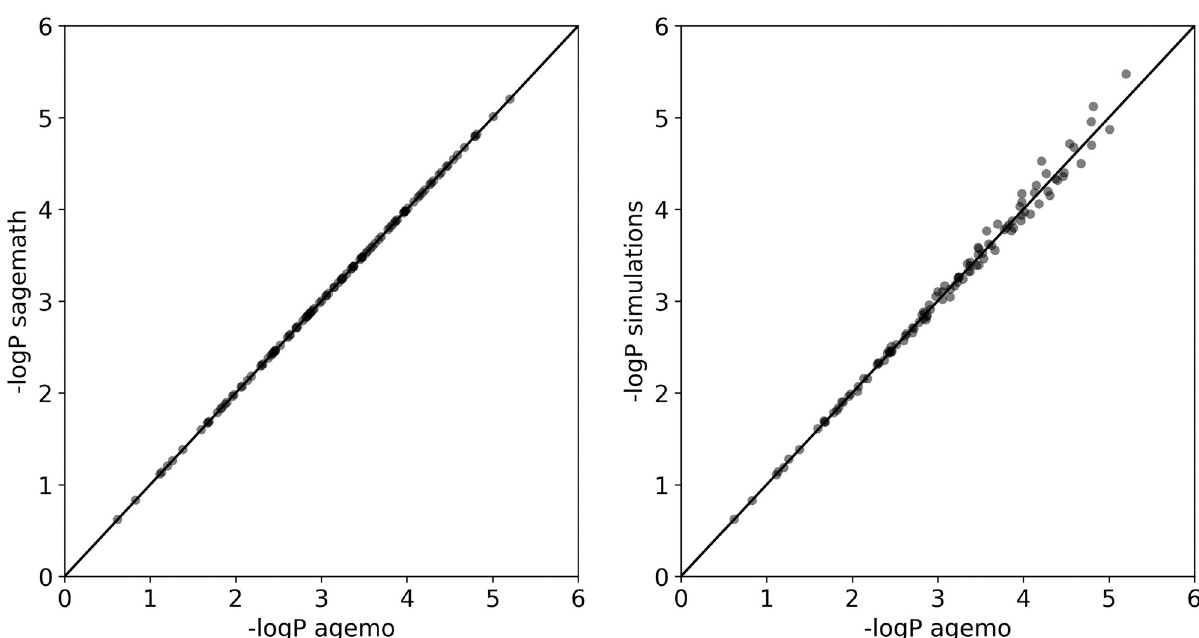
Fig 3. Accuracy: These scatter plots compare the negative logarithm of the computed probability ( − logP ) of observing each block-wise mutation configuration with a non-zero probability. The output of an independent Sagemath implementation (left) or of the Monte Carlo simulation-based approach [23] (right) is plotted against the output of agemo . 1000 simulation replicates were used. Model parameters: IM model, 2 samples per population, migration from A to B (backwards in time). N